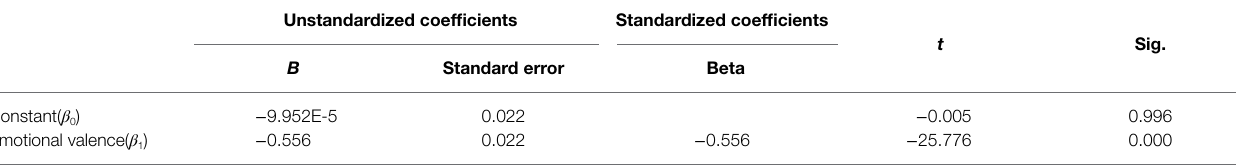
TABLE 11 | Coefficients between reaction time and emotional